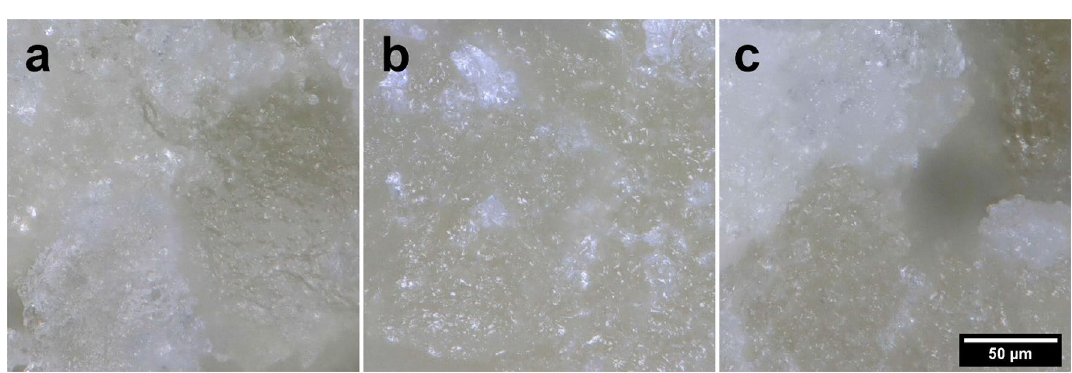
Figure 5. Images of gluten-free bread samples taken with an optical microscope: ( a ) control; ( b ) 2-min treatment; ( c ) − 10-min